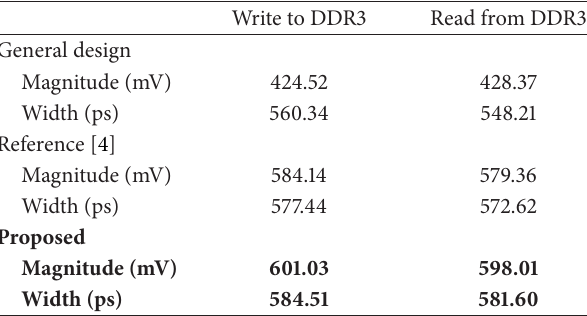
Table 5: The details of eye